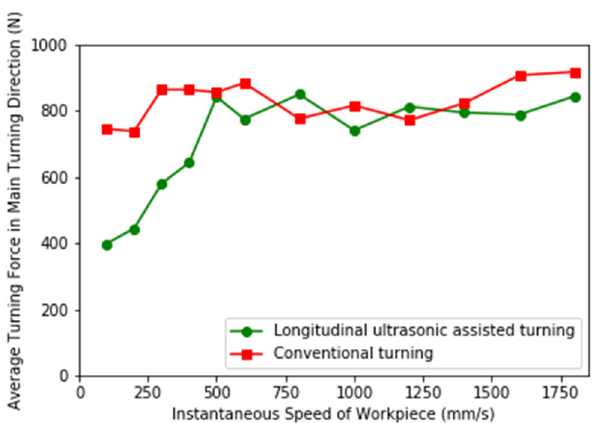
Figure 8. Average cutting force of LUAT and conventional turning (CT).